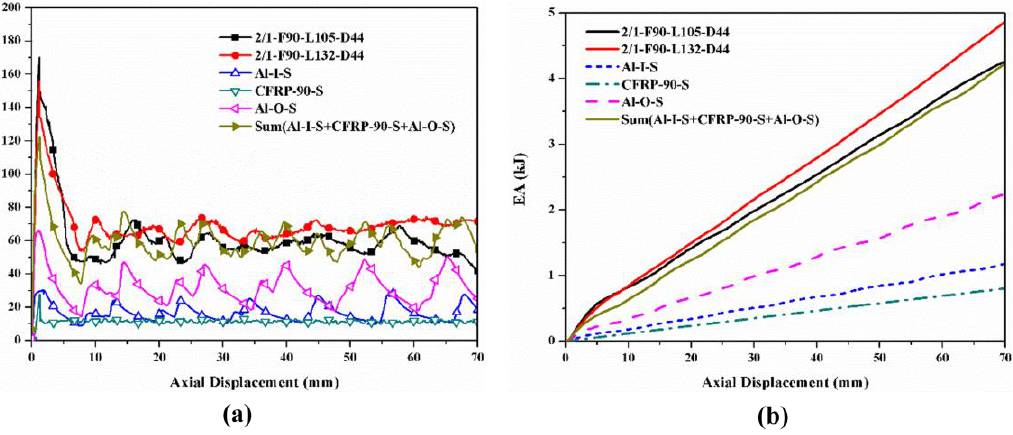
Figure 17. Hybrid effect of 2/1 hybrid tube with nominal outer diameter of 44 mm: ( a ) axial load – displacement curves; ( b ) EA – displacement curves.